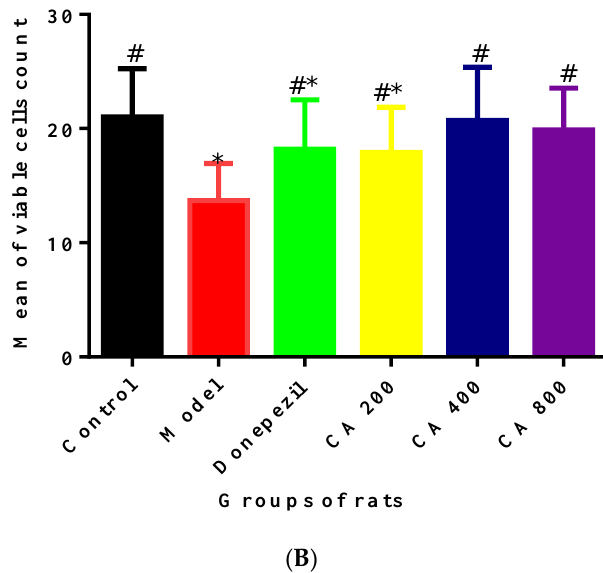
Figure 4. Protective effects of CA against D -gal and AlCl 3 induced neurodegeneration in CA3 sub region of the rat’s hippocampus. ( A ) Cresyl violet stain showing the control and treatment groups. Red arrows pointing to normal pyramidal cells while black arrows pointing dead pyramidal cells. ( B ) Semi quantitative analysis of the number of normal pyramidal cells in the CA3 region of the hippocampus of all the rats groups.